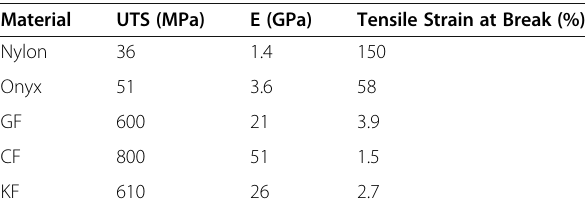
Table 1 Material properties for the matrix and reinforcement materials [26]